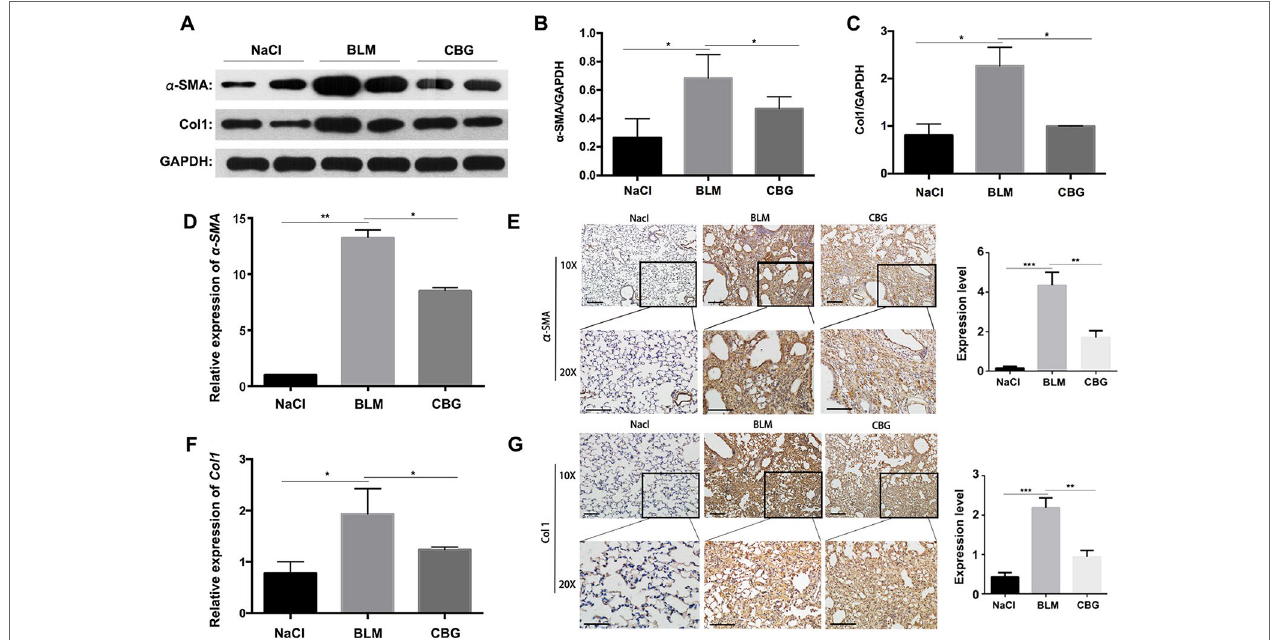
FIGURE 8 | Cinobufagin attenuates BLM-induced myofibroblast differentiation and ECM deposition in vivo . (A) Western blot analysis of the protein levels of α -SMA and Col1 in lung tissues. (B, C) Densitometric analysis of α -SMA and Col1a1 in the immunoblots, using GAPDH as the internal reference. (D, F) Real-time PCR was performed to detect the mRNA levels of α -SMA and Col1a1 in the pulmonary tissues derived from each group. (E, G) Immunohistochemical staining of α -SMA and Col1-positive cells in the lungs. Data are expressed as the means ± SD (n = 6), *P < 0.05; **P < 0.01; ***P < 0.01.